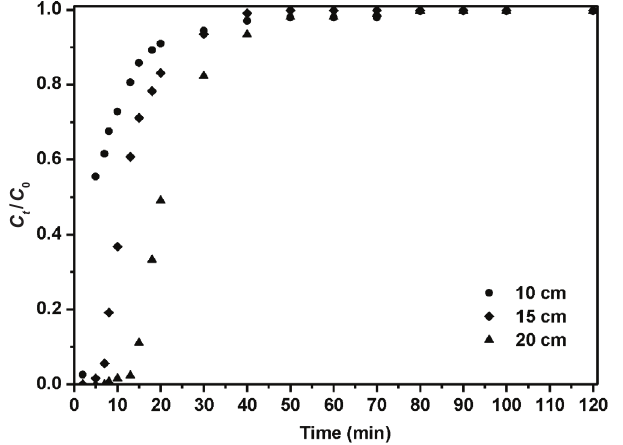
Fig. 4 – Effect of bed height on breakthrough curves for ad- sorption of acrylic acid onto